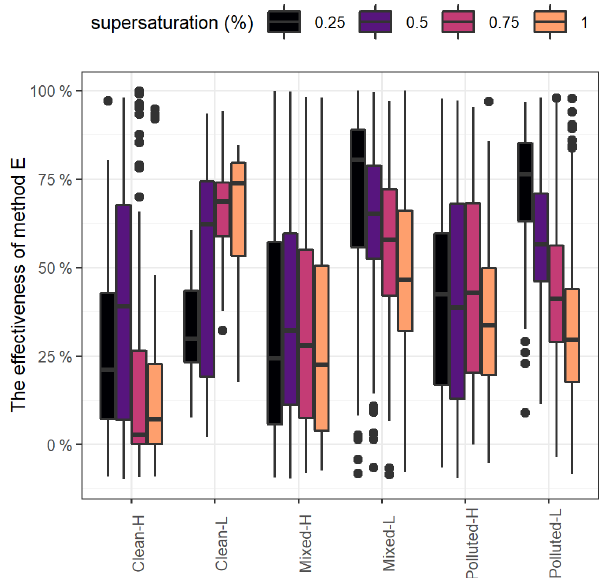
Figure 7. The effectiveness of the three hygroscopicity modes (method E) in the real mixing state scenario (method F), as defined in Eq. (18). The lines represent medians, the boxes represent 25th to 75th quantiles, the whiskers represent the 1.5 interquartile, and the points represent